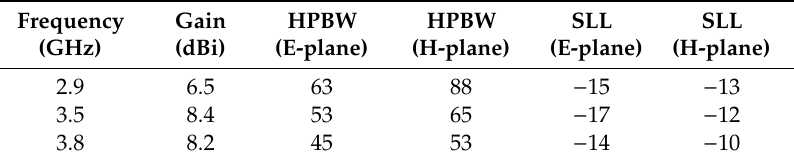
Figure 7. Measured and simulated reflection coefficient response of the printed Yagi antenna. Table 3. Summary of the proposed antenna radiation characteristics.